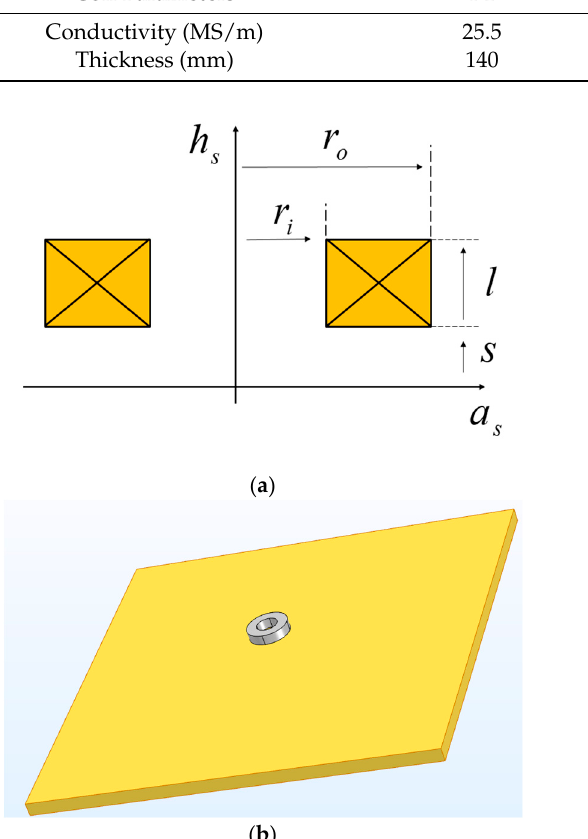
r , outer radius r , a i o